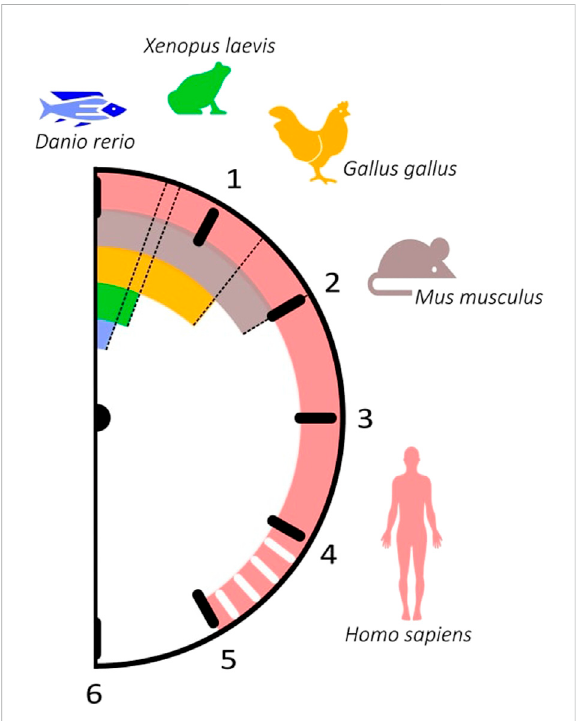
FIGURE 2 The somitogenesis clock ticks with different paces among vertebrates. The periodicity of somitogenesis clock gene expressionindifferentorganismscorrelateswithsomiteformation time. Danio rerio : 30 min (blue); Xenopus laevis: 40 min (green); Gallus gallus : 90 min (orange); Mus musculus : 120 min (brown); Homo sapiens : ~5 h